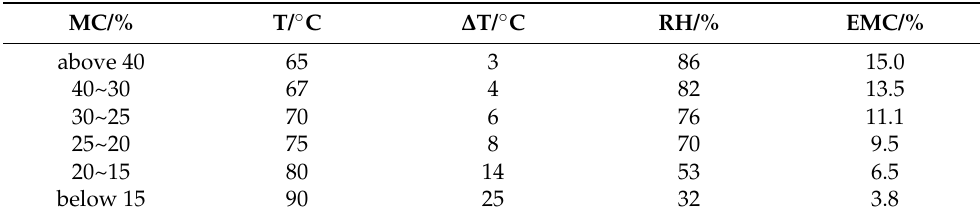
Table 2. Schedule used for conventional drying of Mongolian Scotch